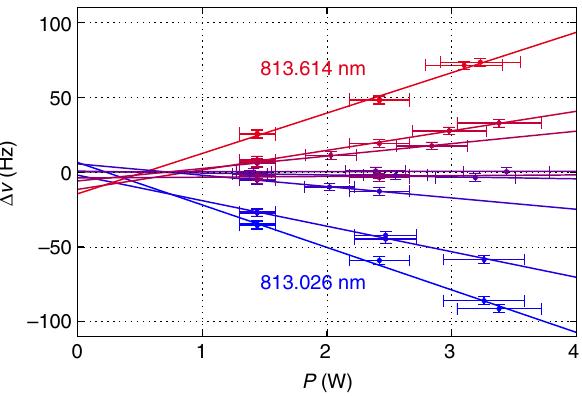
Fig. 5 Clock transition frequency shift measurements. Clock transition frequency shift Δ ν as a function of optical lattice power P in the vicinity of the magic wavelength λ m = 813.32 nm. The solid lines are linear fi ts to the experimental data. The horizontal error bars correspond to uncertainty (1 s.d.) of the power measurements, and the vertical error bars are the mean squared transition line center fi t errors and 2.6 Hz (1 s.d. of the clock laser output